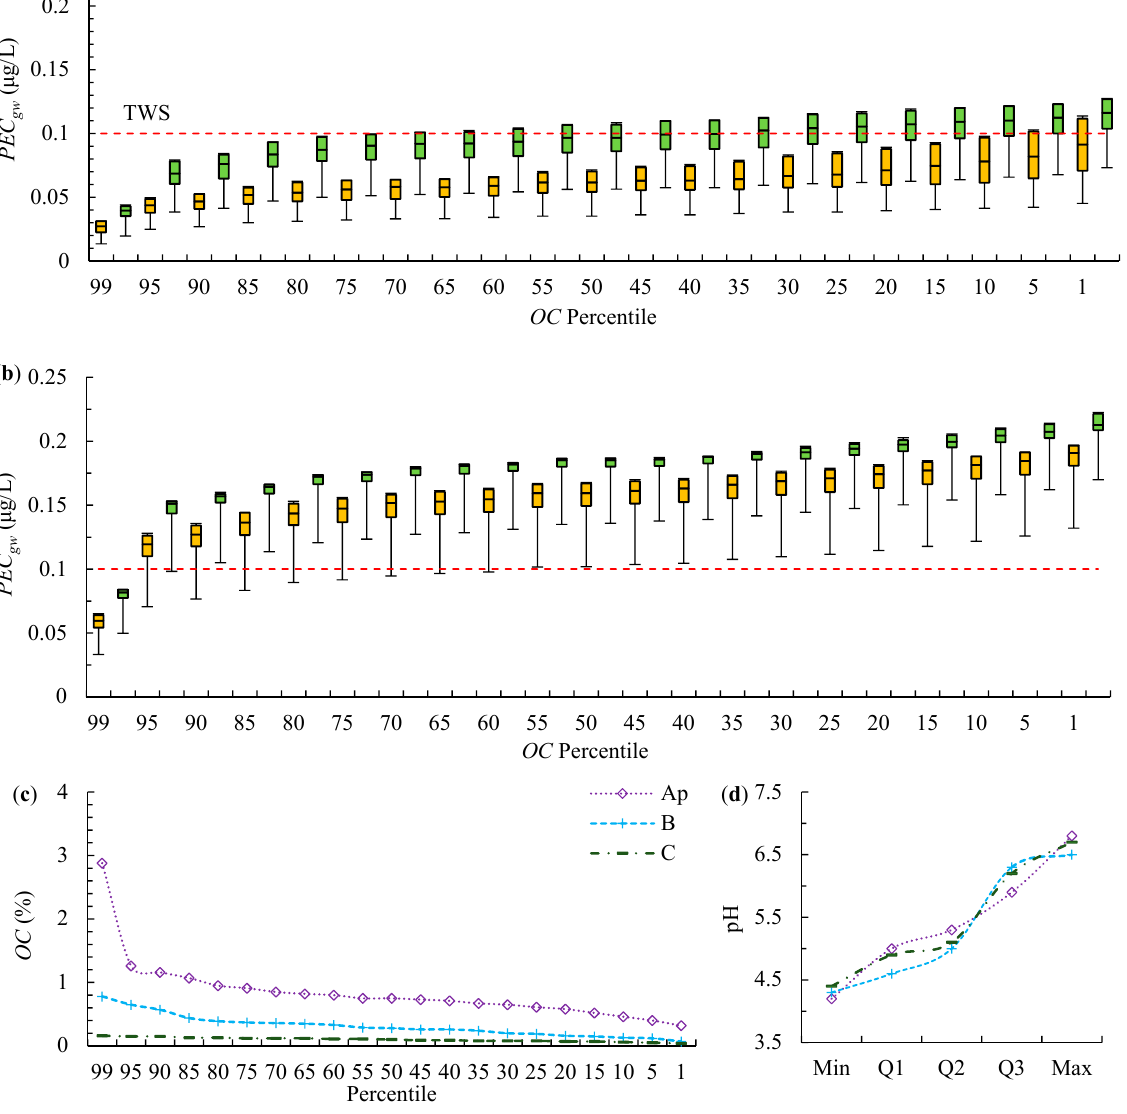
Figure 4. Predicted values of PEC gw for potato and maize cultivation in the model of LV profiles with varied OC content and pH for: ( a ) Lublin and ( b ) Hamburg climate. Box and whiskers plots denote the values of PEC gw estimated for the respective percentiles of OC content at minimum, first quartile (Q1), median (Q2), third quartile (Q3), and maximum pH values. ( c ) Percentiles of OC contents and ( d ) range of pH values of LV profiles.